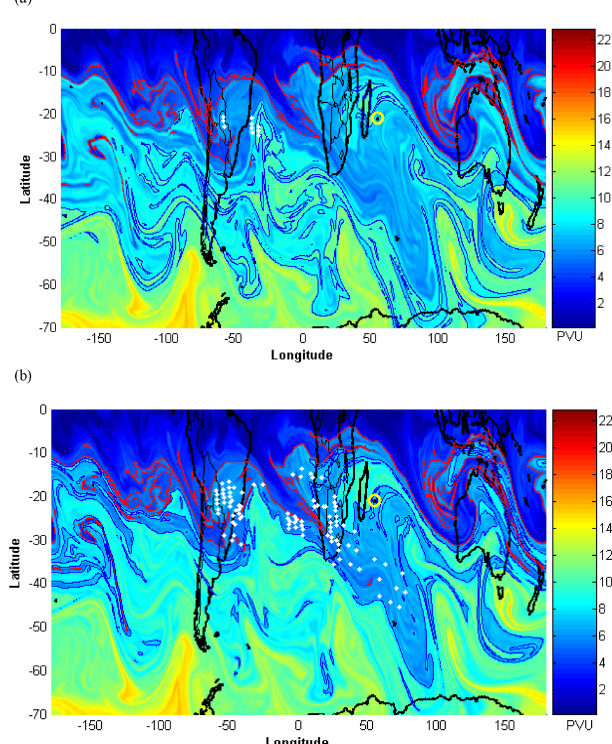
Figure 11. Advected PV map at the 400K level obtained from the MIMOSA model (a) on 27 April 2015 and (b) on 1 May 2015. The positions of the subtropical barrier (red line) and a south dynamical barrier (blue line) are detected from the DyBAL code. The white dots represent the localization of the aerosol plume at 400K ± 5K obtained from OMPS observations, while the yellow circles indicate the Reunion